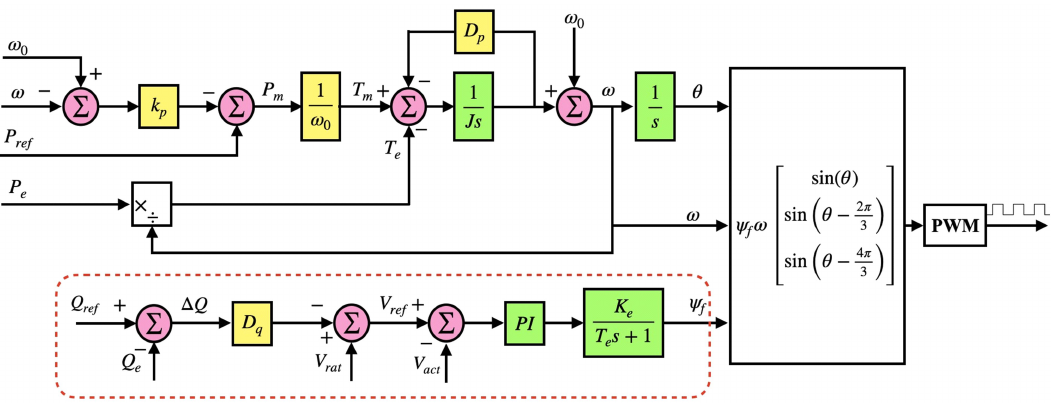
Figure 2. VSG basic control